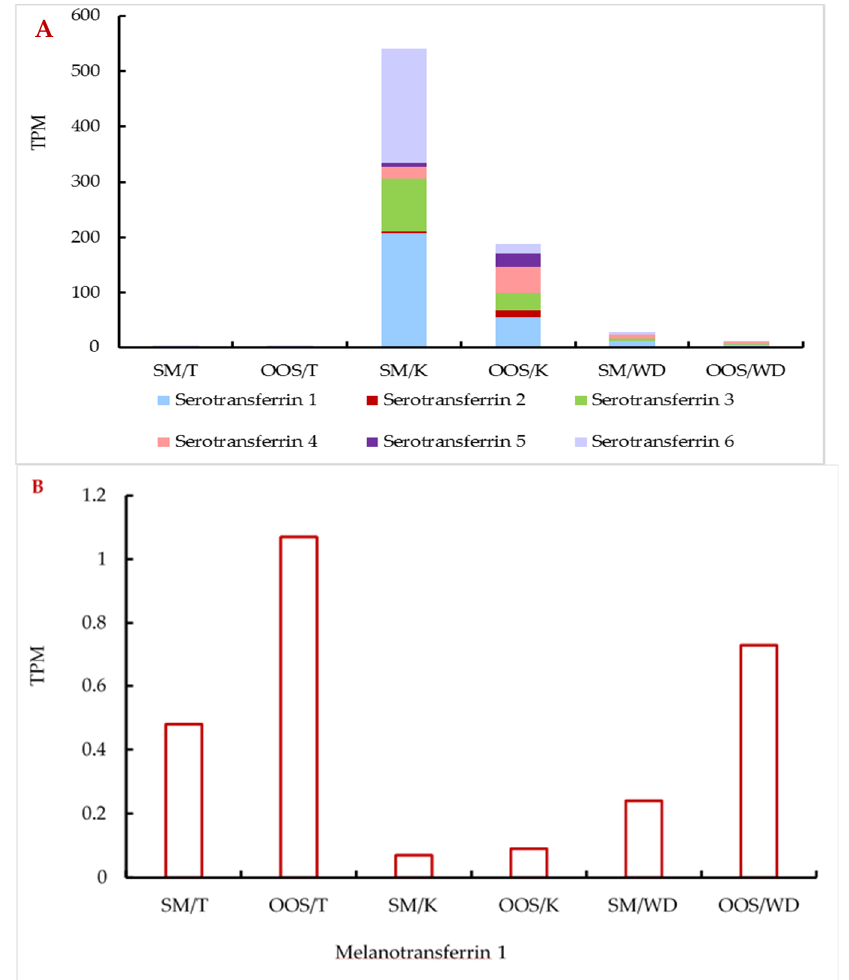
Figure 3. Relative abundances (TPM) of serotransferrin ( A ) and melanotransferrin ( B ) transcripts in the individual organs of both the mature and out-of-spawning sterlet males. ( A ) also shows the ratio of individual serotransferrin isoforms in each sample. SM: spermiating; OOS: out-of-spawning; K: kidney; WD: Wolffian duct; T: testes. Table 2. Relative abundances (TPM) of the sterlet serotransferrin and melanotransferrin isoforms in the studies samples.